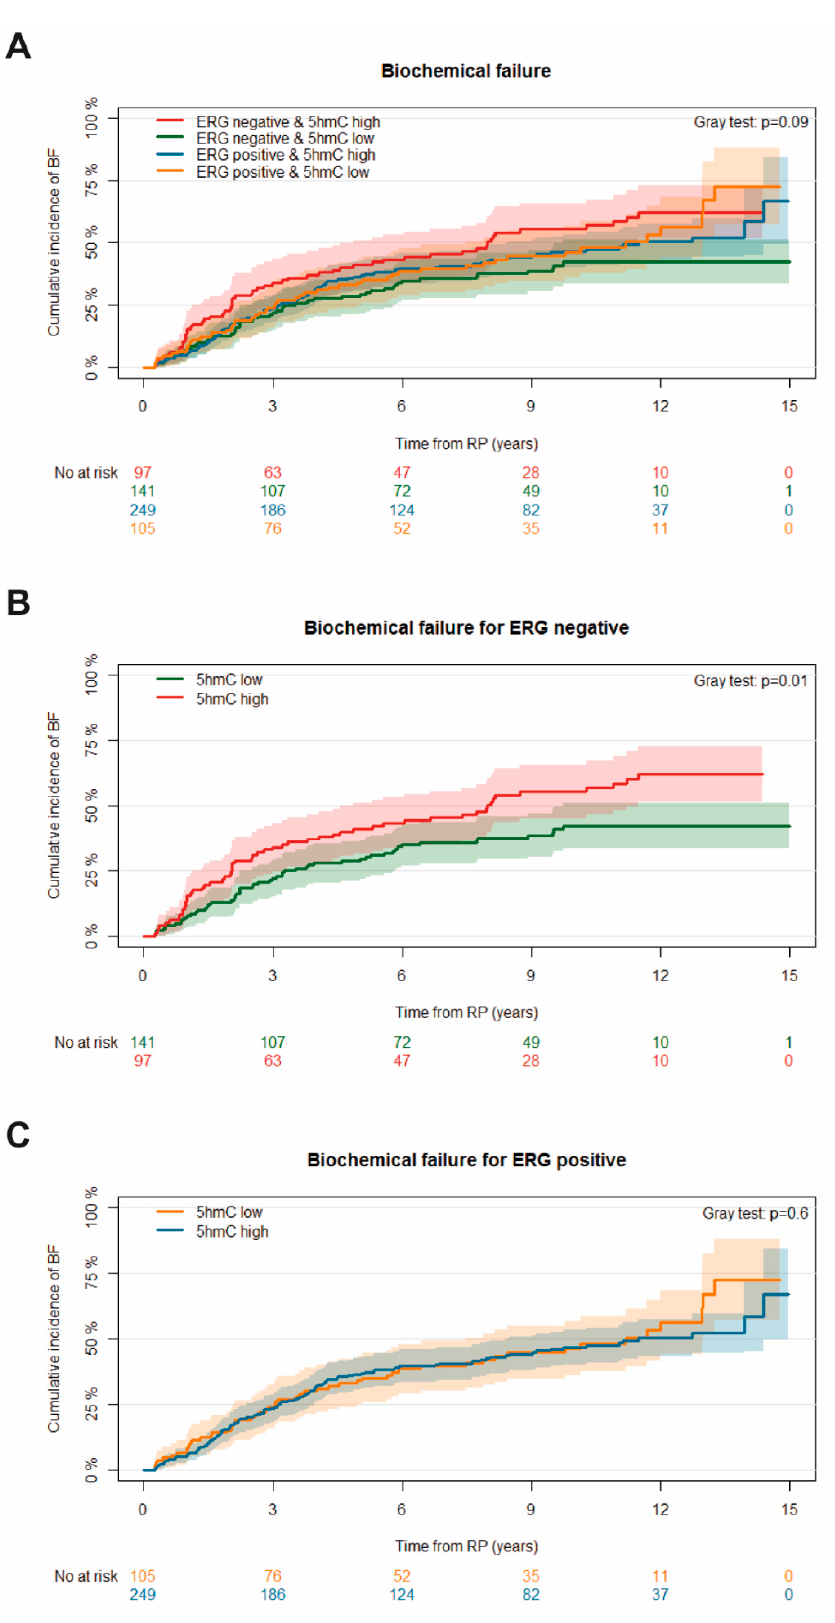
Figure 2. The cumulative incidence of biochemical failure (BF) following radical prostatectomy (RP). Competing events are death without BF. Patients are stratified according to ( A ) biomarker status and 5hmC level for ( B ) ERG negative and ( C ) ERG positive, respectively. The p -values for Gray’s test are added.